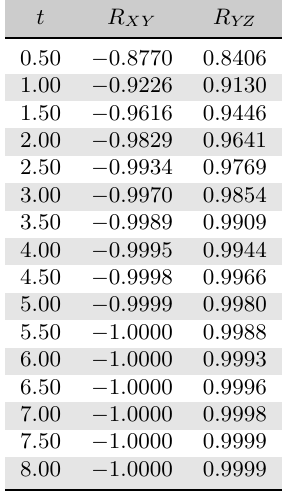
Table 2: R XY and R YZ versus t for α = 100.0, λ = 0.20, µ = 0.10.